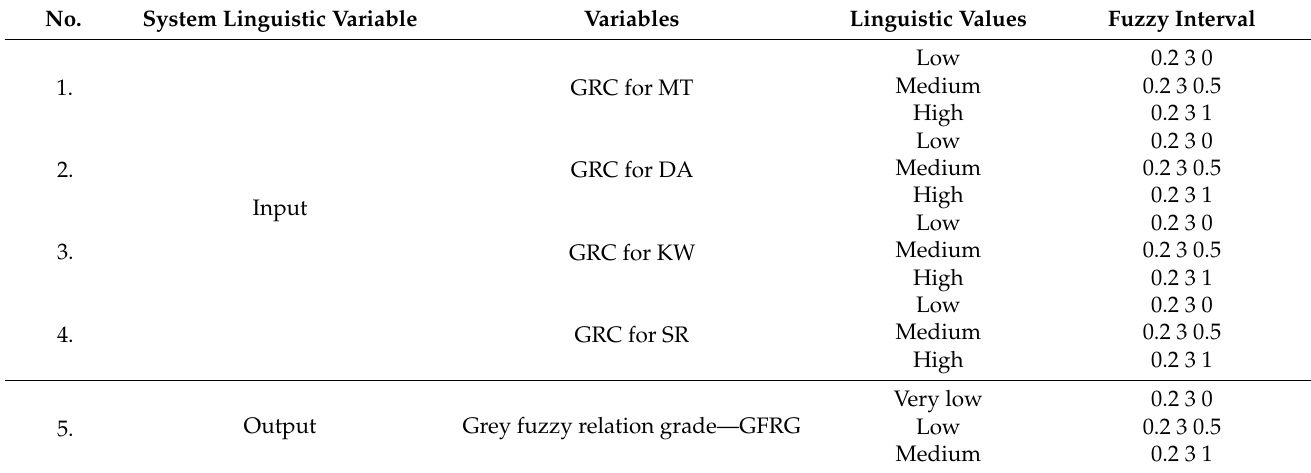
Table 6. Inputs, outputs, linguistic values, and fuzzy